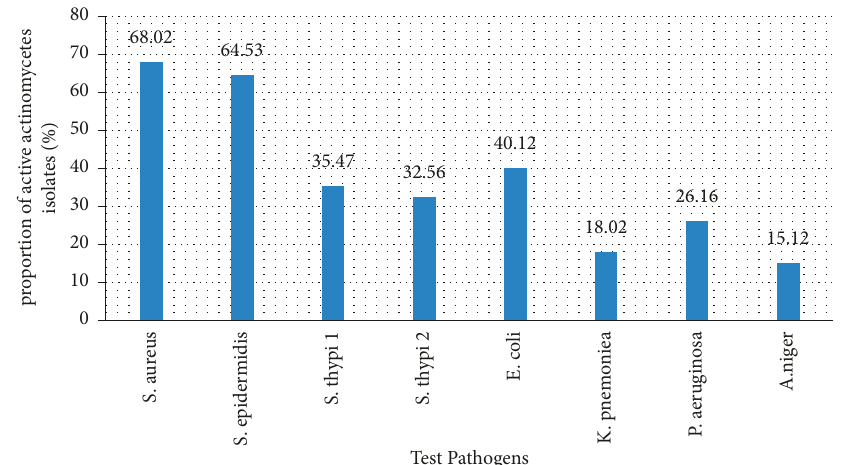
Figure 2: Proportion of active actinomycetes against different test pathogens.